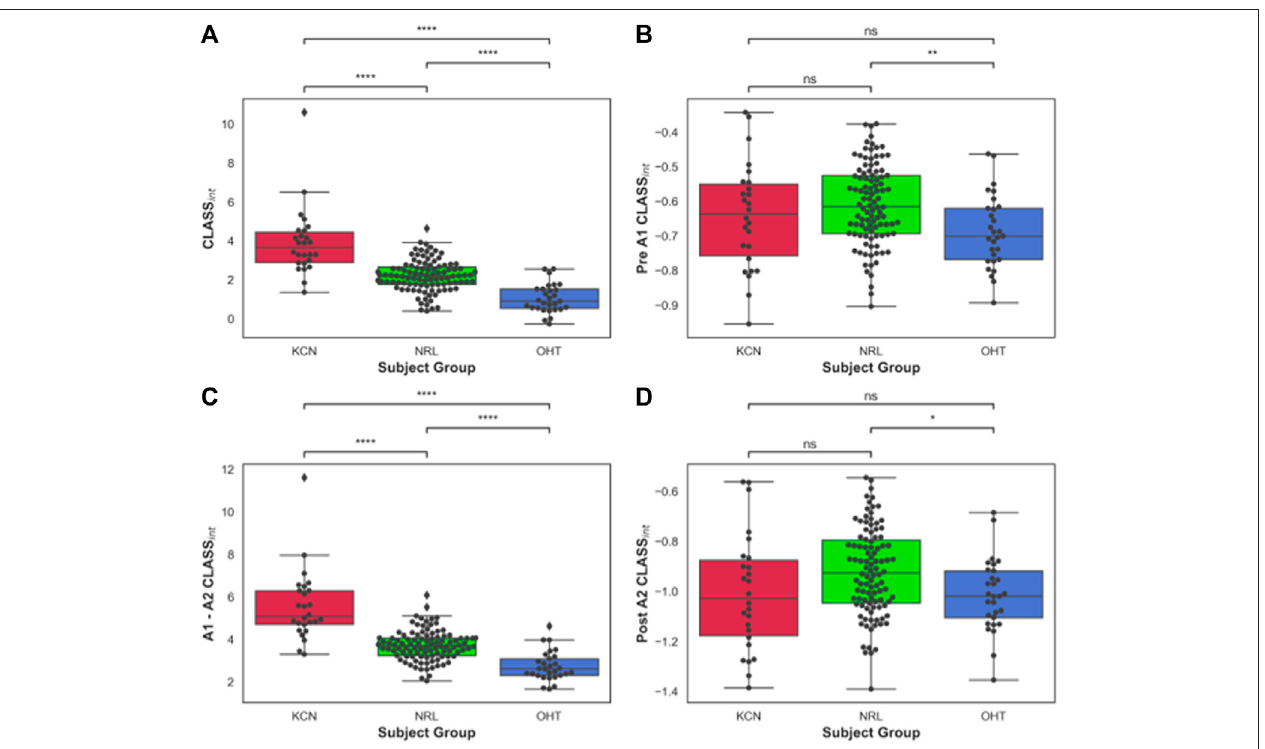
FIGURE 3 | (A) Area under CLASS curve ( CLASS nt ) prior to fi rst applanation for keratoconus (KCN), normal (NRL), and ocular hypertension (OHT) subjects; (B) CLASS int between the two applanation points for KCN, NRL, and OHT subjects; (C) CLASS int after second applanation for KCN, NRL, and OHT subjects. (D) Total CLASS int for KCN, NRL, and OHT subjects. P -value annotation legend: ns: 0.05 < p , *: 0.01 < p ≤ 0.05; **: 0.001 < p ≤ 0.01; ***: 0.0001 < p ≤ 0.001; ****: p ≤